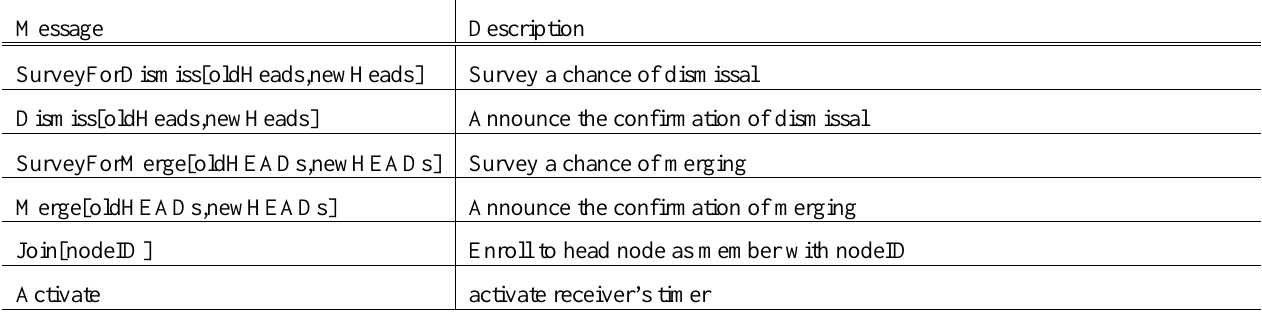
Table 1. Messages and their role among nodes.